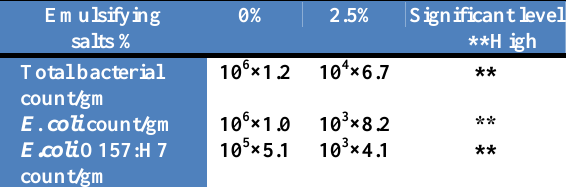
Table, 6: The effect of adding mixture (2) a ratio of (2 .5%) on total bacterial count and E. coil O157:H7